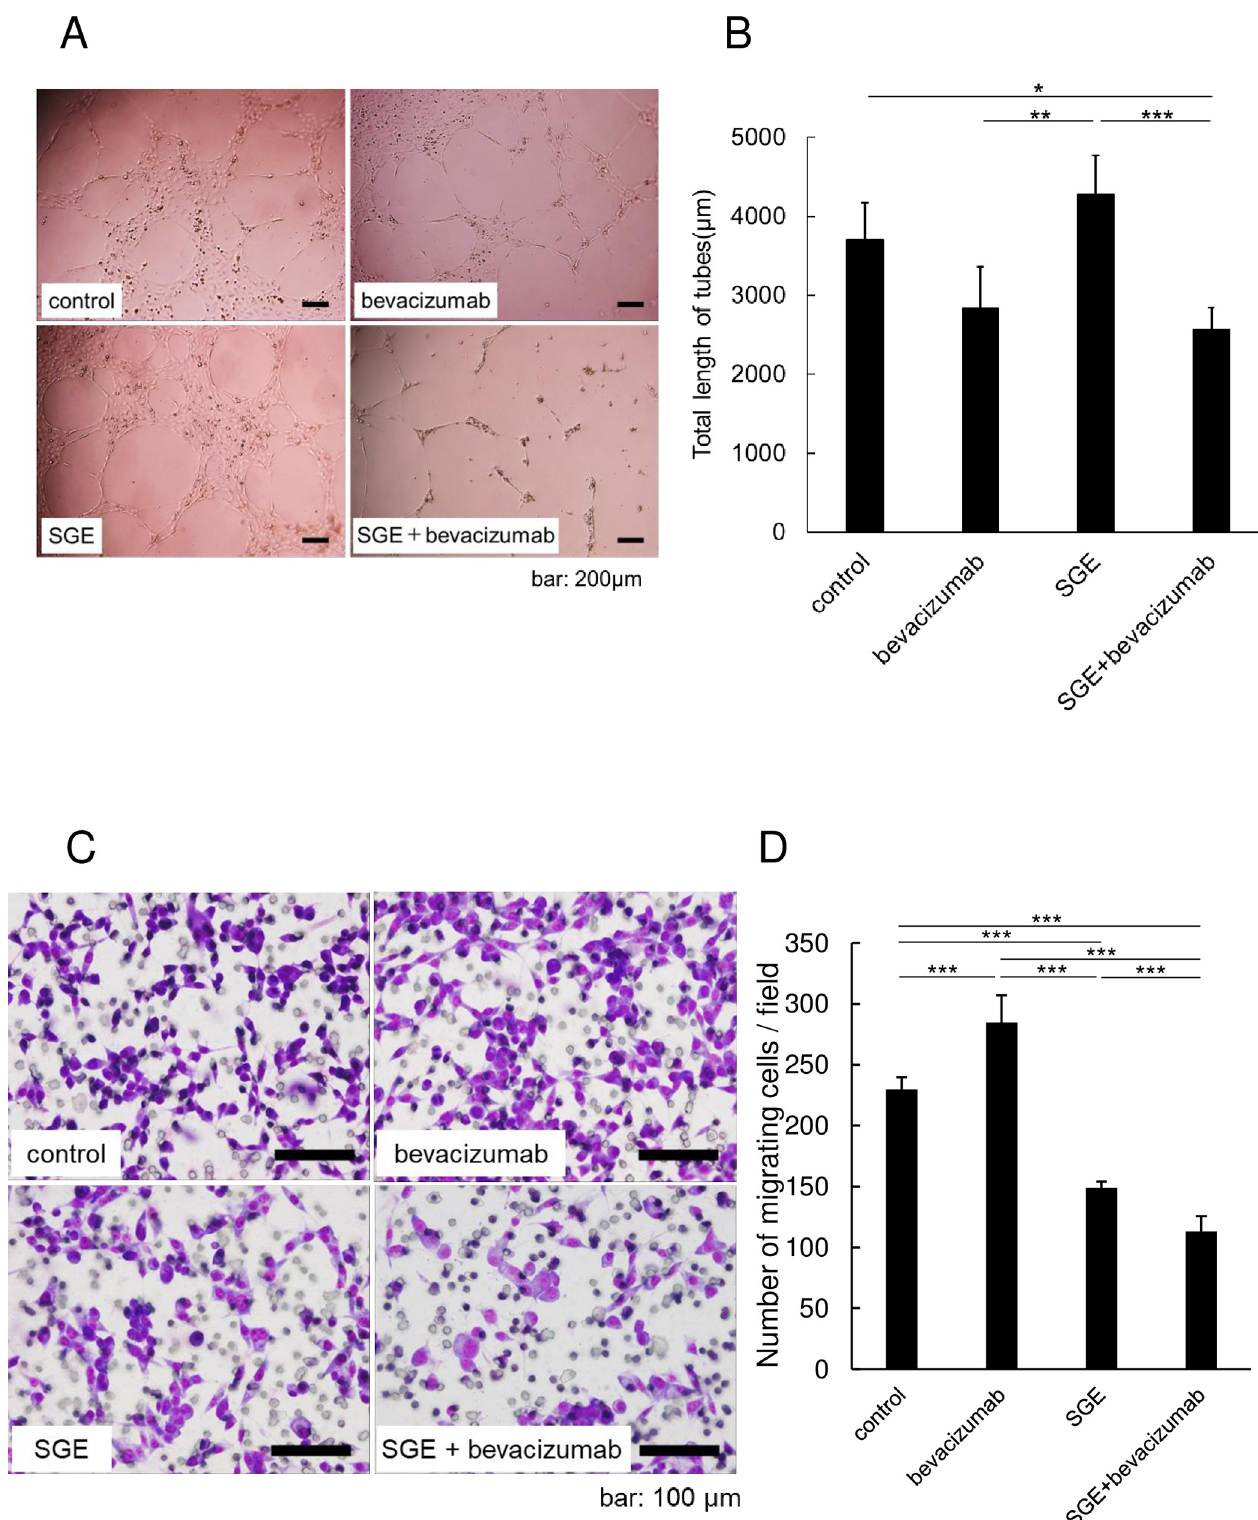
Fig 2. Inhibition of endothelial cell tube formation. Human umbilical vein endothelial cells (HUVECs) were treated with medium containing vascular endothelial growth factor (VEGF)-A along with Ad-SGE-REIC and/or bevacizumab and then assayed by a KURABO Angiogenesis Kit. (A) Representative